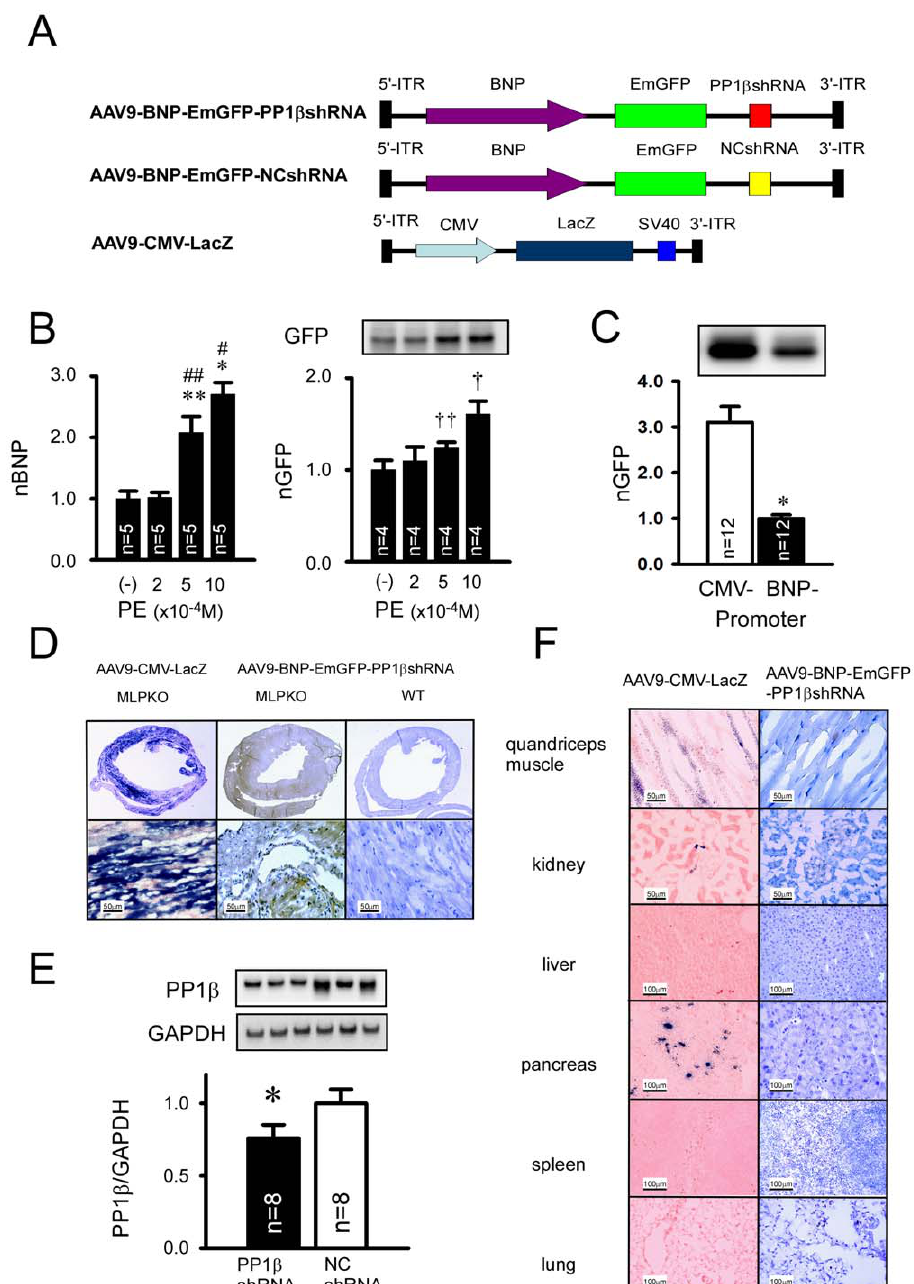
Figure 4. AAV9- mediated heart-failure-inducible PP1 b shRNA and partial reduction in PP1 b expression. A : Vector structure of the adeno-associated virus 9 (AAV9) -PP1 b shRNA flanked by 3 9 and 5 9 inverted terminal repeats (ITR) under the control of the brain natriuretic peptide (BNP) promoter and marker gene expressison of EmGFP. The negative control sequence of miR was used as a shRNA control sequence (NCshRNA). AAV9 vector expressing lacZ driven by the CMV promoter was used to assess the in vivo transfection efficiency through the tail vein injection of AAV9 gene transfer into the heart. B : The expression levels of BNP mRNA and EmGFP protein were dose-dependently increased with phenyrephrine (PE) in the pZAC2.1-BNP-EmGFP-PP1 b shRNA (AAV9 vector plasmid) transfected HL-1 cells. ‘‘*’’ indicates p , 0.001 vs PE( 2 ),‘‘ # ’’ indicates p , 0.001 vs PE 1 6 10 2 4 M, ‘‘**’’ indicates p , 0.05 vs PE 2 6 10 2 4 M, ‘‘ ## ’’ indicates p , 0.01 vs PE 2 6 10 2 4 M, ‘‘ { ’’ p , 0.05 vs PE( 2 ),‘‘ {{ ’’ p , 0.05 vs PE 2 6 10 2 4 M. (nBNP; normalized BNP expression, nGFP; normalized EmGFP expression). C : Comparison of EmGFP expression levels with BNP- versus CMV- promoter. The normalized EmGFP expression levels were estimated 48 hours after plasmid transfection of pDC316-CMV-EmGFP-PP1 b shRNA and pZAC2.1-BNP- EmGFP-PP1 b shRNA in HL-cells. ‘‘*’’ indicates p , 0.01 vs the CMV promoter treated group. D : Bluo-gal staining of transverse heart sections at the papillary muscle level in AAV9-CMV-LacZ transfected MLPKO mice (left panel), and immunostaining of EmGFP proteins in the AAV9- BNP-PP1 b shRNA transfected hearts in MLP knockout mice(middle panel) and wild type mice (right panel). The expression level of EmGFP was clearly detected by an anti-GFP antibody (Abcam) as a brown color in the GFP-immunostaining indicates positive cardiomyocytes. The scale bar indicates 50 m m. E : Immunoblotting of PP1 b in LV homogenates from the transfected MLP knockout hearts with AAV9-BNP-EmGFP-PP1 b shRNA and AAV9- BNP-EmGFP-NCshRNA. The graph under the immunoblot indicates quantitative analysis of PP1 b expression normalized by GAPDH. PP1 b expression levels were decreased by 25% in the PP1 b shRNA treated group. ‘‘*’’ indicates p , 0.05 vs. NCshRNA treated group. (n=8 in each group). F : Bluo-gal